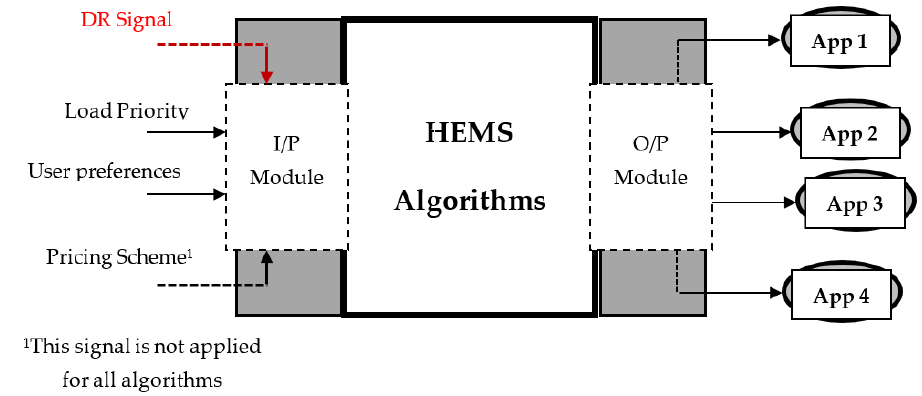
Figure 4. Input/output modules with signals of HEMS algorithms.